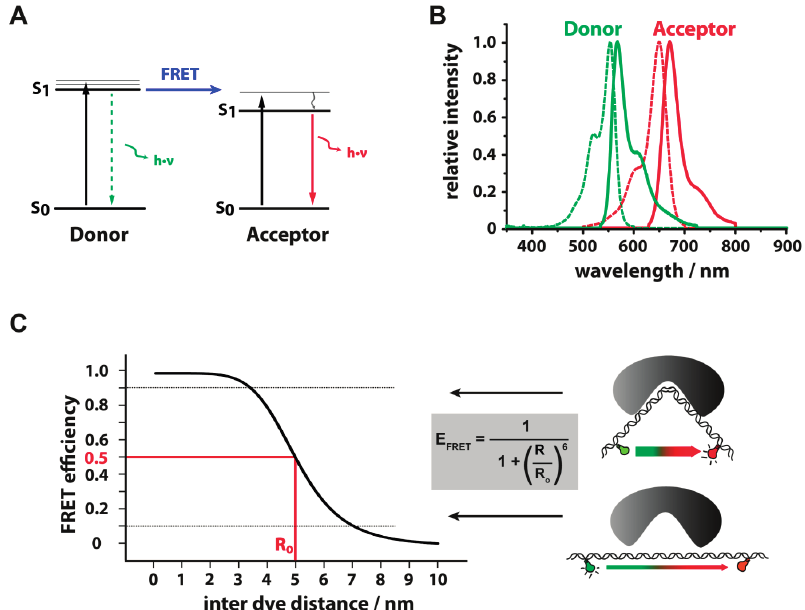
Figure 3. Principles of fluorescence resonance energy transfer (FRET). ( A ) If an excited donor fluorophore is in close proximity (approximately 1–10 nm) to an acceptor fluorophore, radiation-less energy transfer to the acceptor fluorophore via dipole-dipole interaction (FRET) competes with radiative return (photon emission) of the donor to its ground state (dotted arrow). The acceptor, now in its excited state (S 1 ), can then return to its ground state (S 0 ) by the emission of a photon and the ratio of photons emitted by the donor and acceptor molecule defines the transfer efficiency; ( B ) FRET occurs only if the emission spectrum of the donor dye (green continuous line, Alexa555) overlaps with excitation spectrum of the acceptor dye (red dashed line, Alexa647); ( C ) Distance dependency of the energy transfer efficiency between a donor and acceptor fluorophore (assuming a Förster radius R 0 of 5 nm). FRET can inform for example about structural changes in the DNA induced by the transcription factor TBP (TATA-binding protein) [49]. Distance changes can be measured most sensitively when working in the dynamic range between approximately 10%–90% FRET efficiency (dotted